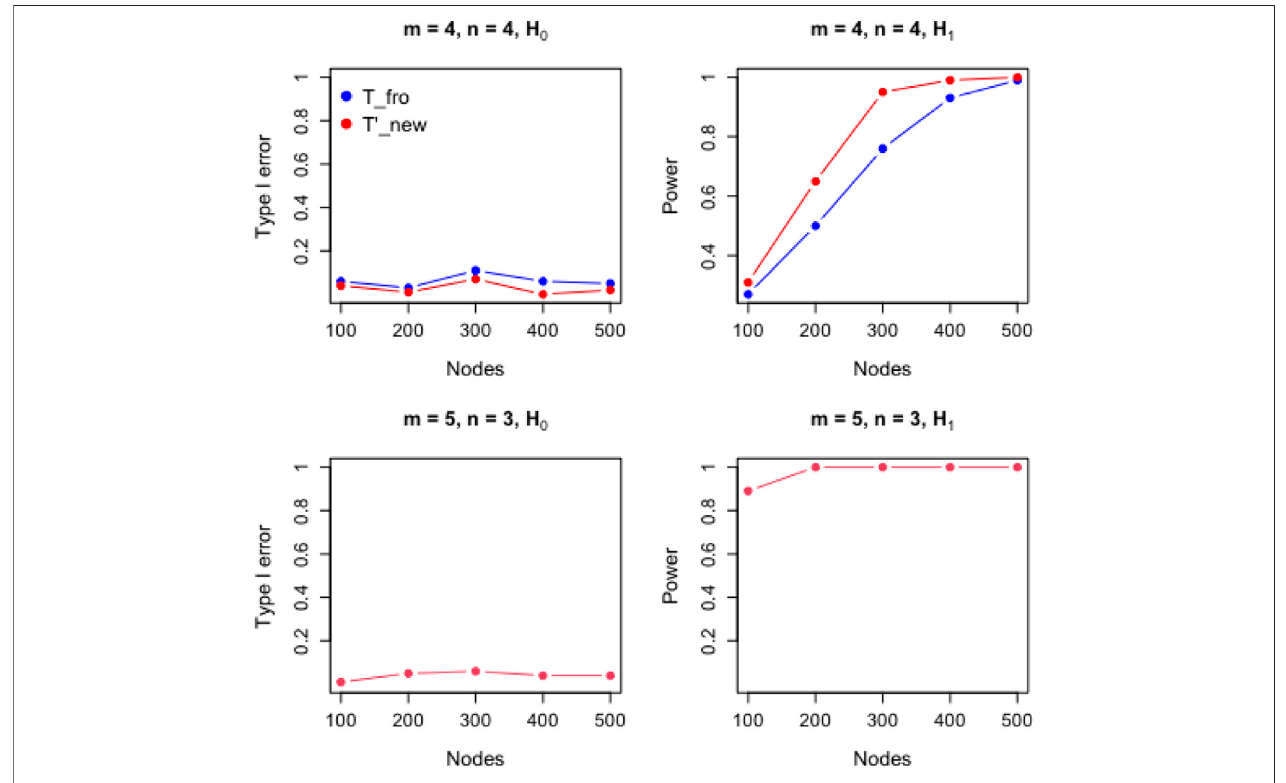
FIGURE 2 | Performance comparison of proposed test for directed graphs.